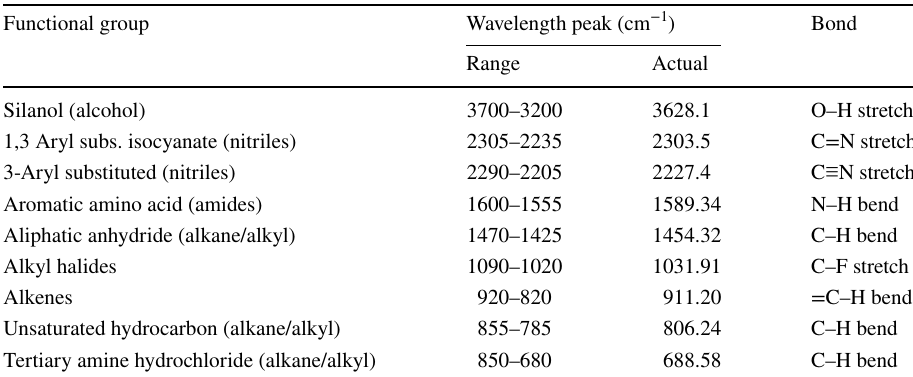
Table 3 FTIR functional groups of the PAC